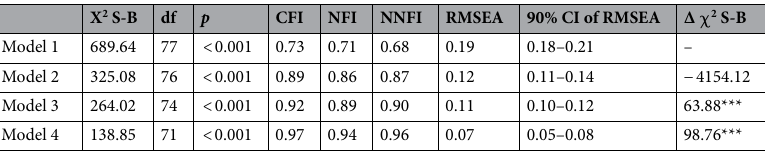
Table 2. Adjustment values for the tested models. Model 1: A single-factor structure; Model 2: Two-factor structure (leadership styles factor and energy factor); Model 3: Three-factor structure (leadership styles, vigor at work and engagement); Model 4: Four-factor structure (TFL, AL, vigor at work and engagement). CFI = Comparative fit index; df = Degrees of freedom; CI = Confidence interval; NFI = Normed fit index; NNFI = Non-normed fit index; RMSEA = Root mean square error of approximation; χ 2 S-B = Satorra–Bentler chi-square; Δ χ 2 S-B = Scaled Satorra–Bentler chi-square difference. *** p <